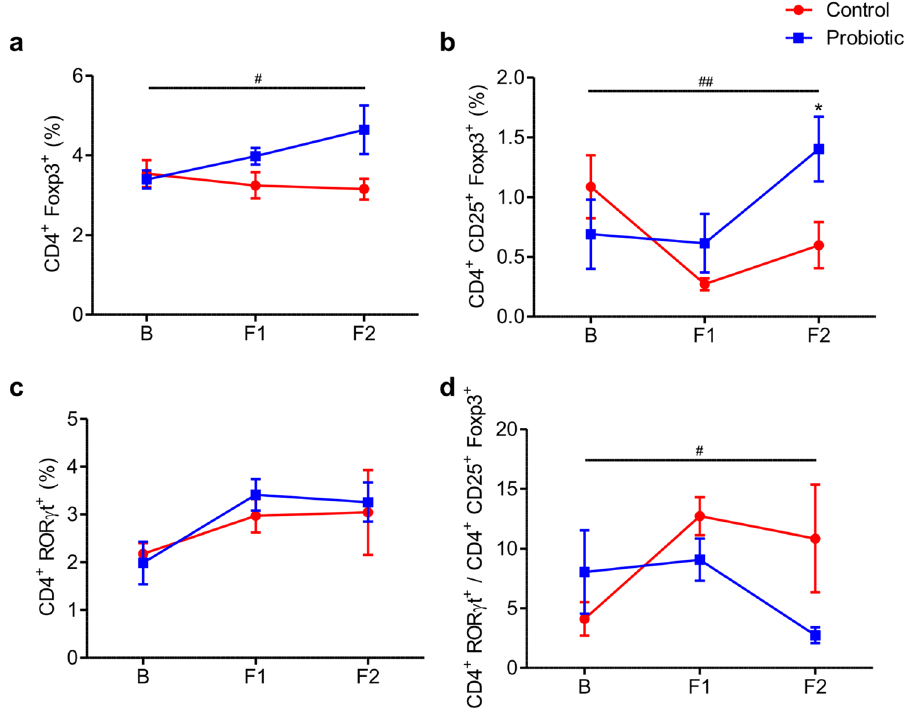
Figure 3. Flow cytometry analysis of T-cells (n = 4–8). Values are mean ± SEM. * P < 0.05 versus control, # P < 0.05, and ## P < 0.01 versus control comparing Δ-values. B, baseline; F1, 1 week after treatment; F2, 2 weeks after